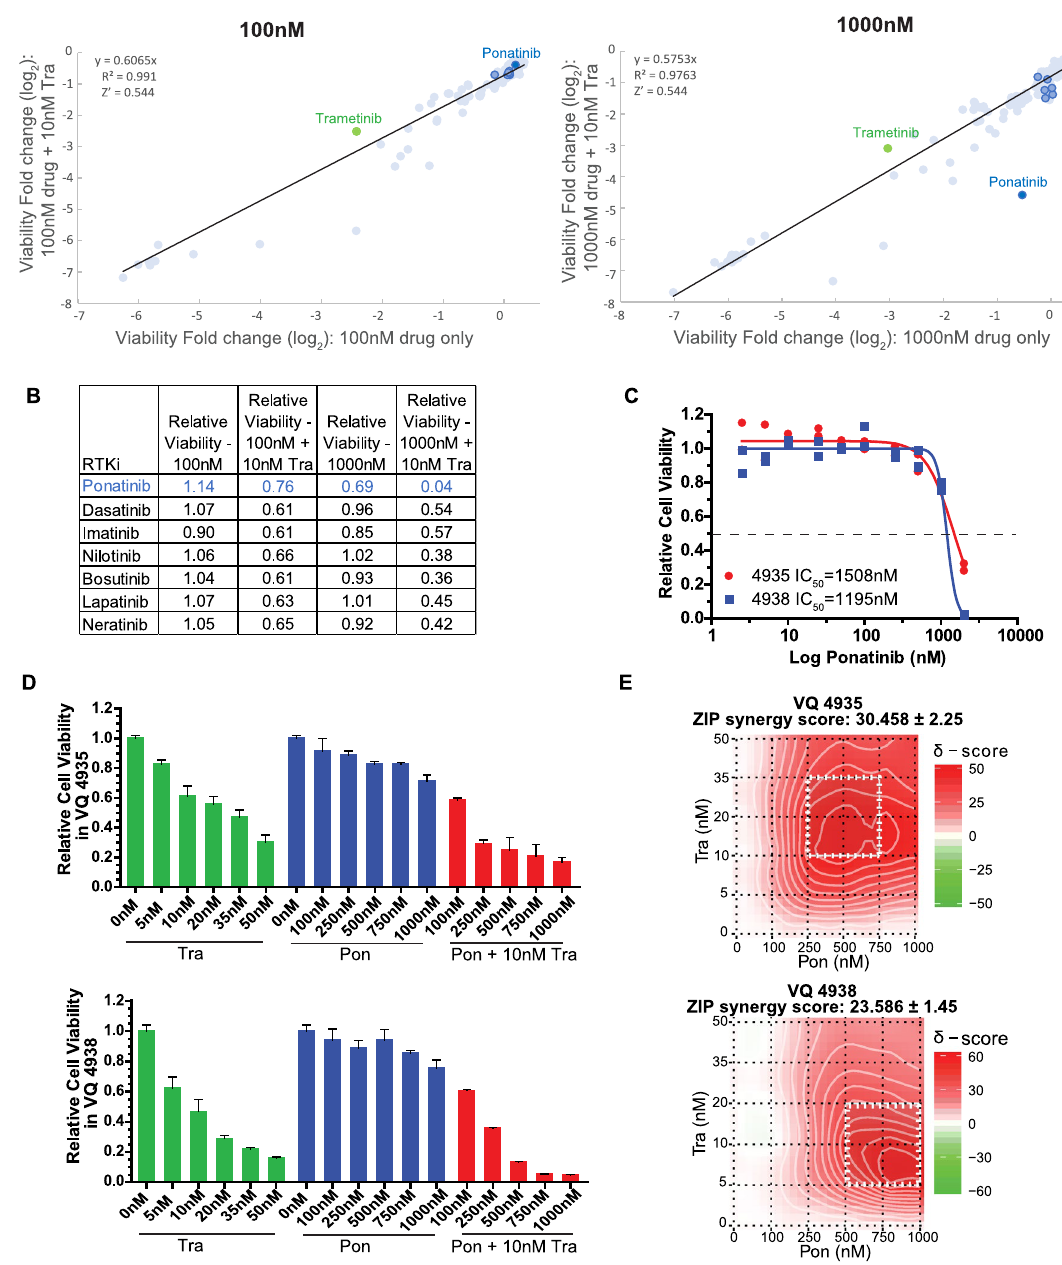
Figure 2. Ponatinib, but not other TKIs, synergizes with trametinib in vitro. ( A ) Relative viability results for tyrosine kinase inhibitors (TKIs) from AOD IX panel at 100 nM and 1000 nM concentration alone or in the presence of 10 nM trametinib, as in Fig. 1A. ( B ) Screening results of TKIs as single agents and with 10 nM trametinib. Trametinib and Ponatinib are highlighted as in ( A ). Of note, 10 nM trametinib yielded ~ 50% viability relative to DMSO control. ( C–E ) VQ 4935 and 4938 cells were treated with the indicated concentrations of two compounds for 48 h. Relative viability to DMSO treated control was then measured using the CellTiter-Glo assay. ( C ) Dose–response results for ponatinib against VQ 4935 and 4938 cell lines. IC 50 values were calculated by logistic regression using the GraphPad Prism software. ( D ) Selected viability results for combination treatment of trametinib (Tra) and ponatinib (Pon) against VQ 4935 and 4938 cells. ( E ) ZIP synergy plots of Tra and Pon in VQ 4935 and 4938 cells. Zip Synergy scores were generated using the SynergyFinder online